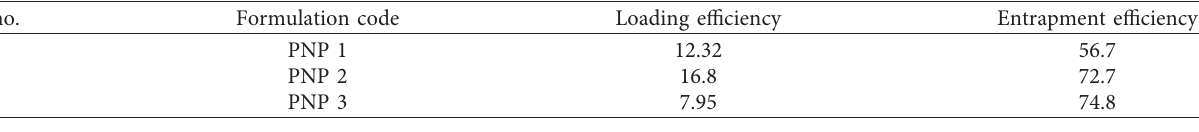
Table 4: Loading and entrapment efficiency.